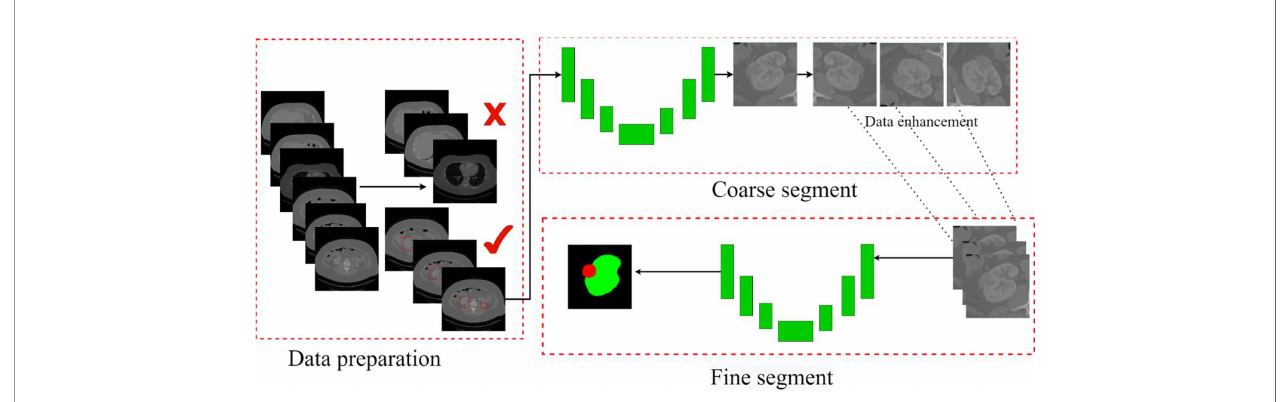
FIGURE 5 | The overall process. Contains three parts: data preparation, coarse segmentation, and fi ne segmentation. Section Data Preparation introduces data preparation in detail, Section Coarse Segmentation Based on FR2PAttU-Net Model introduces coarse segmentation and Section Fine Segmentation Based on FR2PAttU-Net Model introduces fi